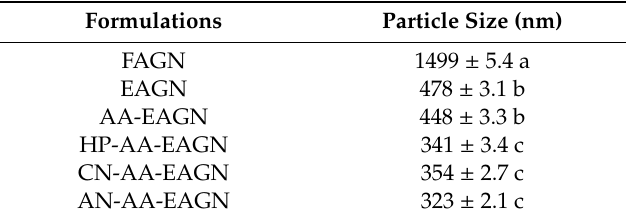
Table 3. Particle size distribution of the AGNC